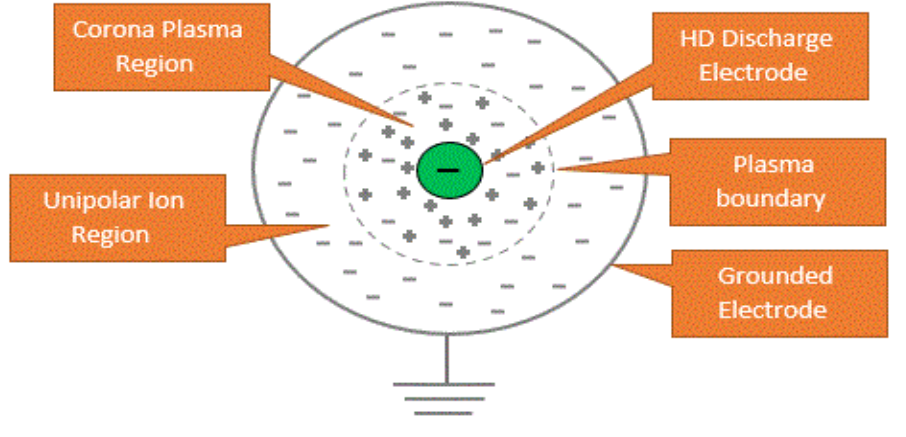
Figure 7. Process of ionization.